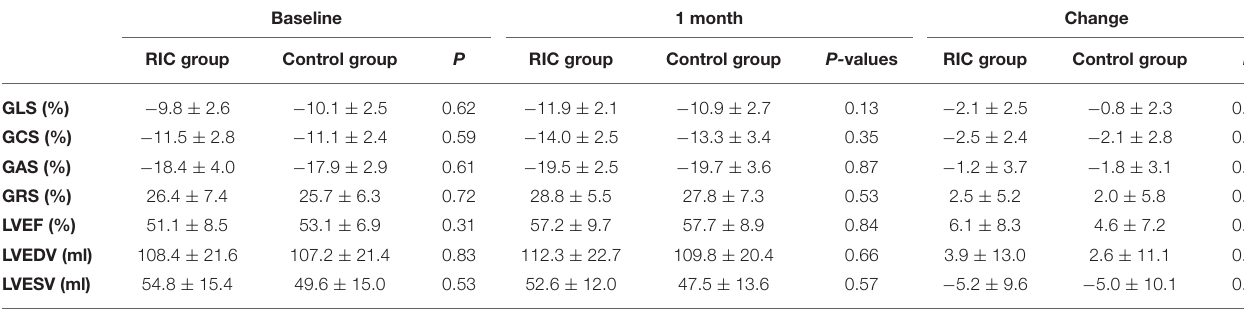
TABLE 2 | 3D echocardiographic data of the RIC group and the control group.